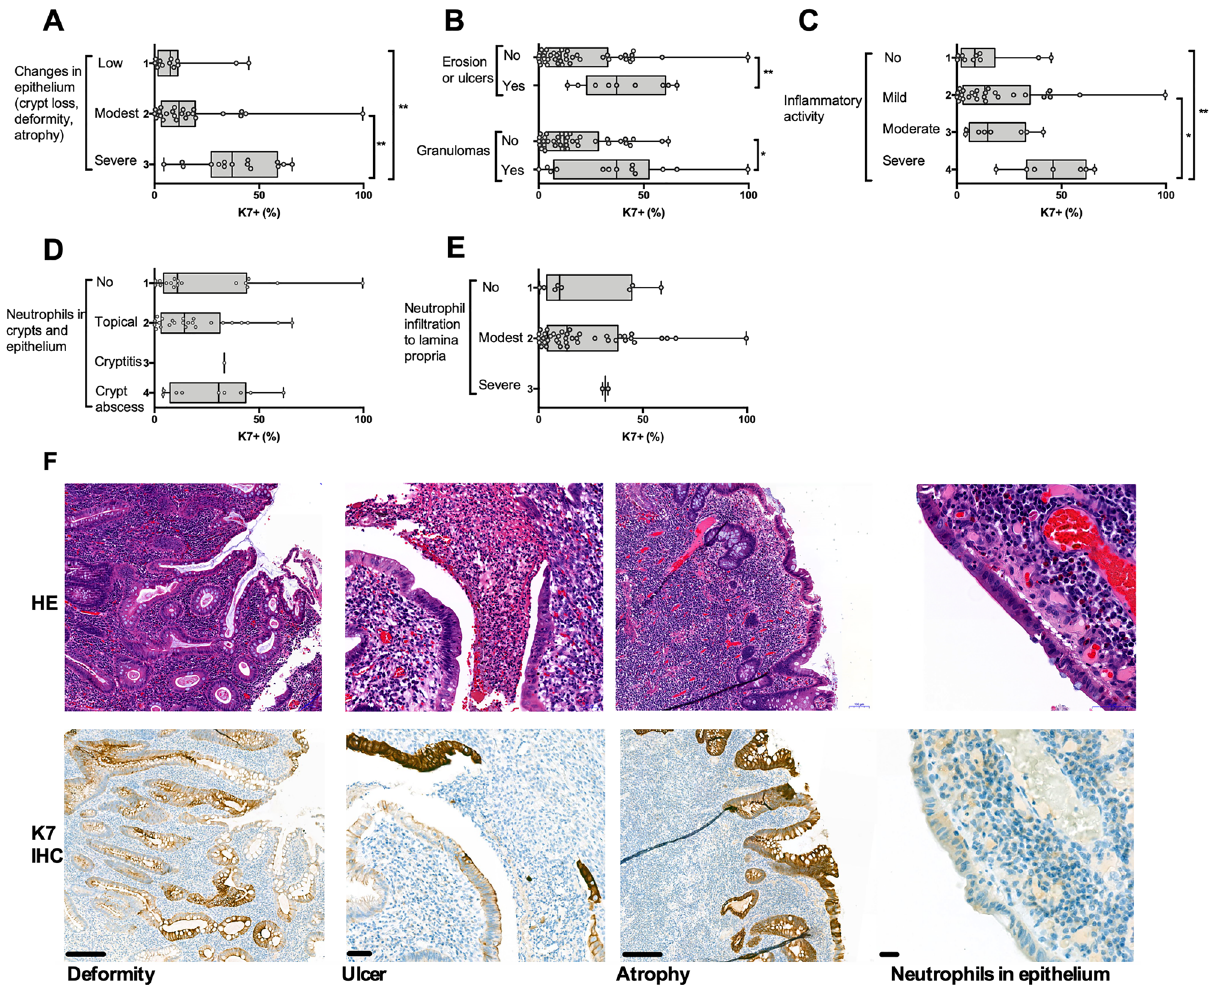
Figure 4. Severe pathological changes in epithelium induce colonic K7. Pathological changes in IBD sample annotations (aROI) in which K7 was quantified (two per patient) show that ( A ) major changes in epithelium, including atrophy, deformity, and crypt loss ( B ) as well as ulcers, erosion and granulomas, are associated with high K7 + percentage. ( C ) Increased inflammatory activity excluding ulcers did not change the percentage of K7 expressing cells, neither did the number of neutrophils in ( D ) epithelial cell layer nor in the ( E ) lamina propria. IBD patient samples presented here belong to cohort A. ( F ) Representative H&E and K7 IHC images of pathological changes are shown for deformity and atrophy (scale bar 200 μm), ulcer (50 μm), neutrophils in epithelium (20 μm). Boxes extend from 25 to 75th percent, line inside shows median values, whiskers min and max values, and grey dots individual sample annotations. The significance between more than two groups was measured using Dunn’s multiple comparison test. Mann–Whitney test in pairwise comparison. Correlations of two variables were estimated using linear regression analysis. *P < 0.05. **P <